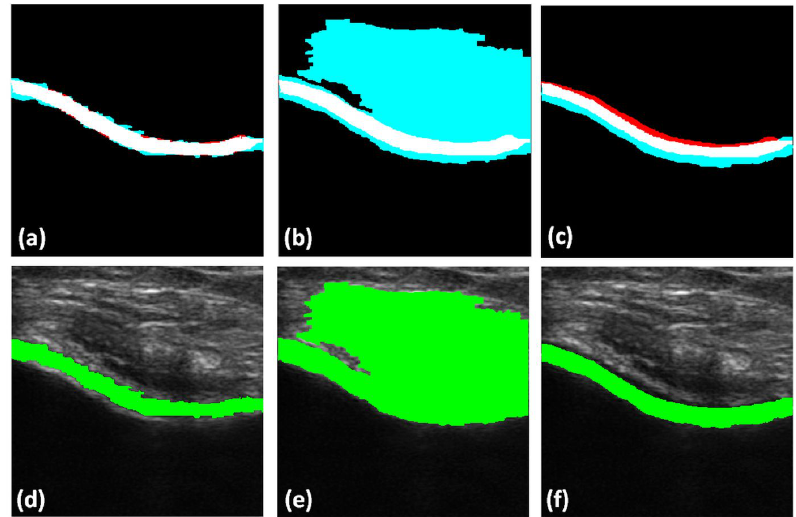
Figure 8. Top row: Qualitative results of automatically segmented cartilage using B-mode US data as an input to the segmentation method, overlaid on expert manual segmentation (red: false negative, magenta: false positive, white: true positive): ( a ) Manual segmentation overlaid with RW segmentation. ( b ) Manual segmentation overlaid on watershed segmentation. ( c ) Manual segmentation overlaid on graph-cut segmentation. Bottom row: automatically segmented cartilage region overlaid on original B-mode US data: ( d ) Cartilage region segmented using RW method. ( e ) Cartilage region segmented using watershed method. ( f ) Cartilage region segmented using graph-cut method.